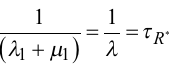
FIGURE 2 Validation of the GWS version of the model. GWS (red triangles) and FSR (open circles) models yielded nearly identical responses to bright flashes in a mouse rod. Only the four brightest flashes were saturating. The lines passing through the associated saturation times was extended to the left with dashed lines. Saturation time, T sat , was measured from mid-flash to 2% recovery (larger symbols). For the purposes of illustration, T sat was measured in the same way for the subsaturated responses to the two weakest flashes. For comparative purposes, T sat was also measured from mid-flash to 20% recovery (smaller symbols). The slope of the Pepperberg relation was unaffected by the change in criterion recovery, but there was an upward translation equivalent to a lateral shift to a lower